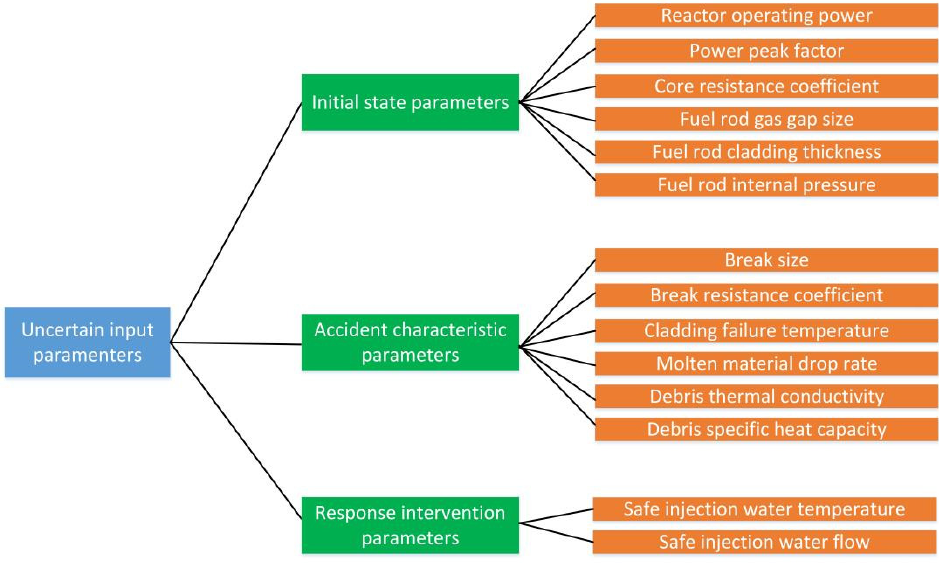
Figure 7. The description of uncertain input parameters. Table 2. Distribution and range of uncertain input